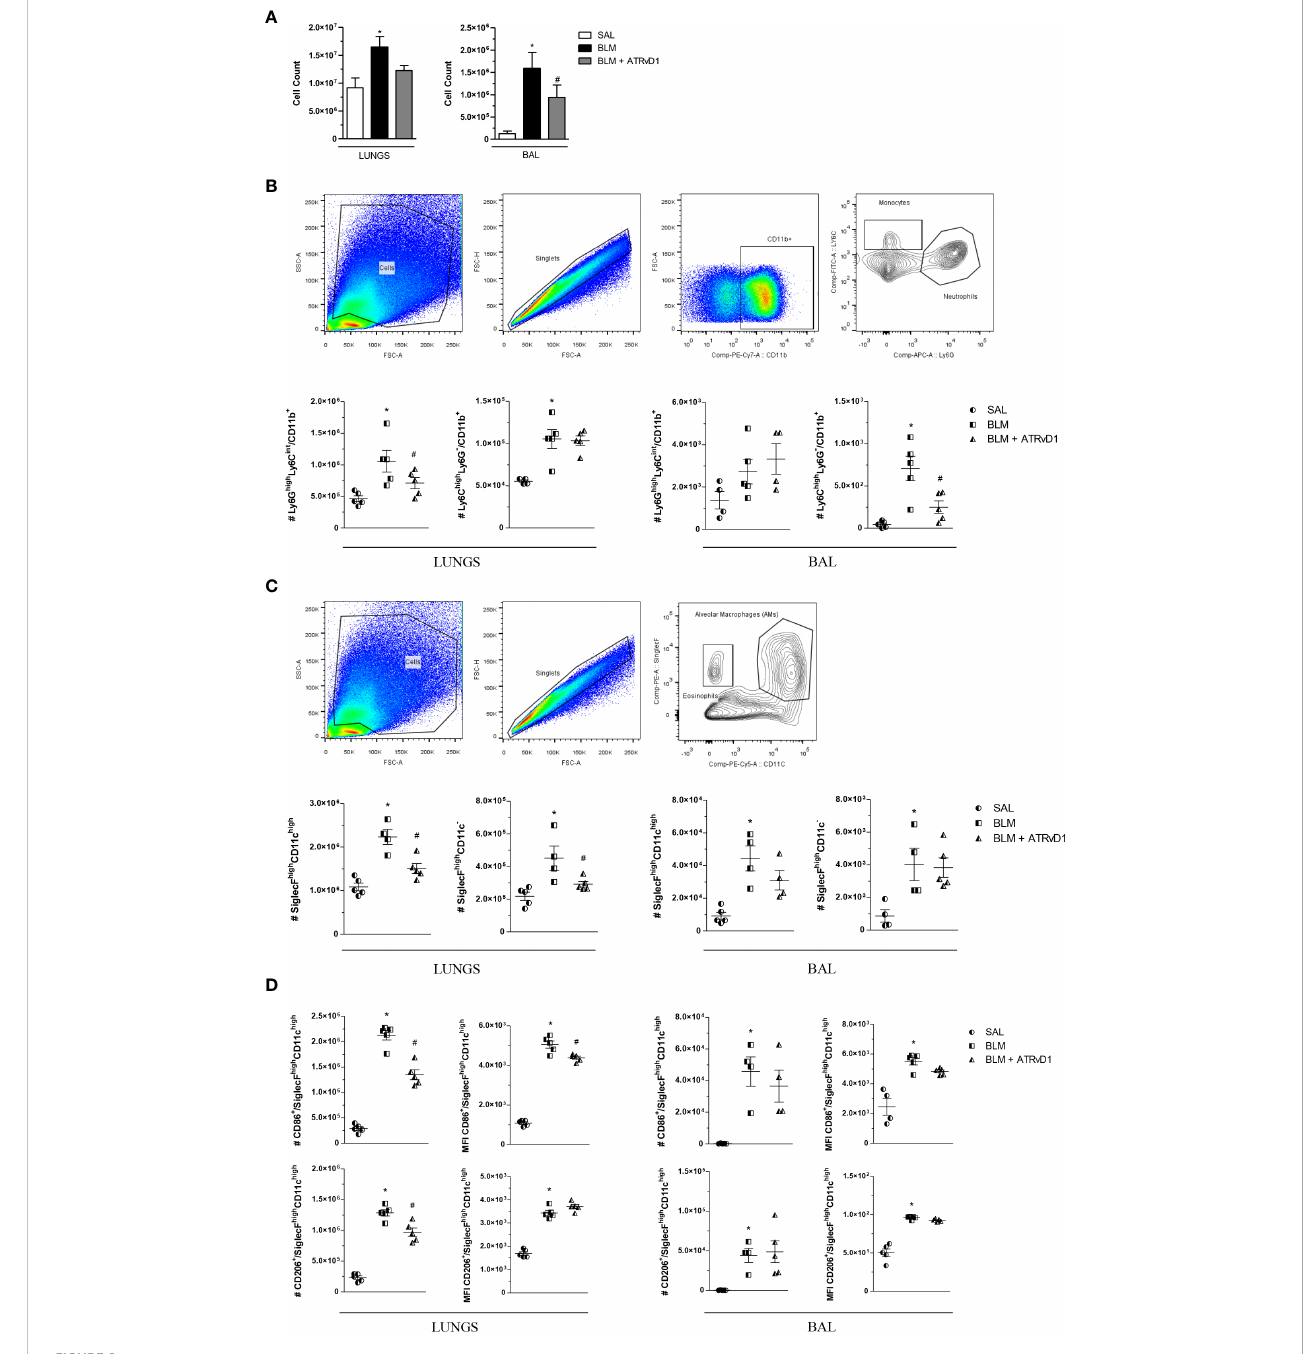
FIGURE 2 ATRvD1 rescues the cell numbers and phenotype in the lung and BAL of BLM-injected mice. (A) Total cell count quanti fi ed in the supernatant after enzymatic digestion of the lungs (left) and after BAL harvest (right). (B) Dot-plot images show the gate strategy for monocyte and neutrophil analysis: (i) forward and side scatter plots show a gated region representing leukocytes; (ii) forward scatter gated region of singlet cells; (iii) forward scatter and CD11b cell expression gated on live cells; (iv) contour plot of Ly6C + and Ly6G + cells. The bottom graphs show the absolute number of the neutrophil (Ly6G high Ly6C int /CD11b + ) and monocyte (Ly6C high Ly6G − /CD11b + ) populations in the lungs and BAL. (C) Dot-plot images show the gate strategy for alveolar macrophages and eosinophils: (i) forward and side scatter plots show a gated region representing leukocytes; (ii) forward scatter gated region of singlet cells; (iii) contour plot of CD11c and SiglecF gated on live cells. The bottom graphs show the absolute number of the alveolar macrophage (SiglecF high CD11c high ) and eosinophil (SiglecF high CD11c − ) populations in the lungs and BAL. (D) Absolute number and MFI of CD86 + or CD206 + cells in the SiglecF high CD11c high population. Results represent mean + SEM from two independent experiments. * P ≤ 0.05 vs. the SAL group; # P ≤ 0.05 vs. the BLM